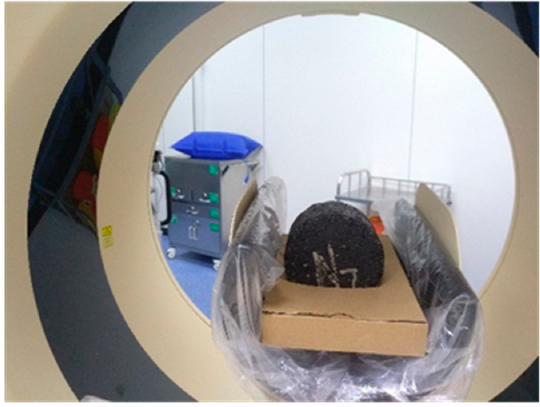
Figure 5. The process of plane scanning.